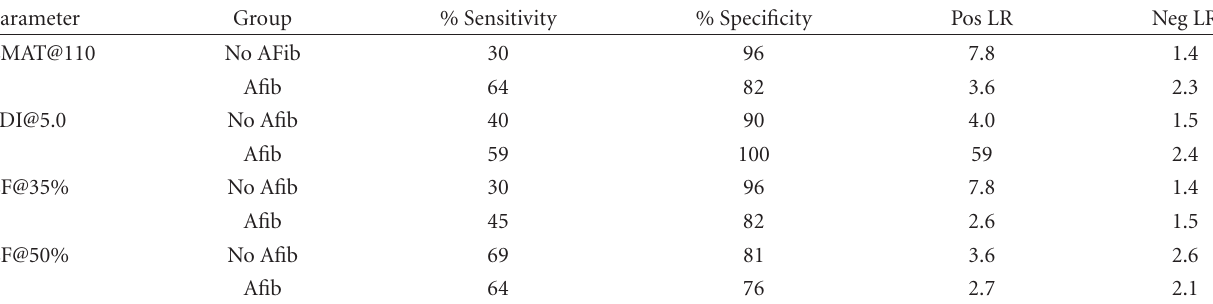
Table 2: Performances of EMAT, SDI, and EF to detect